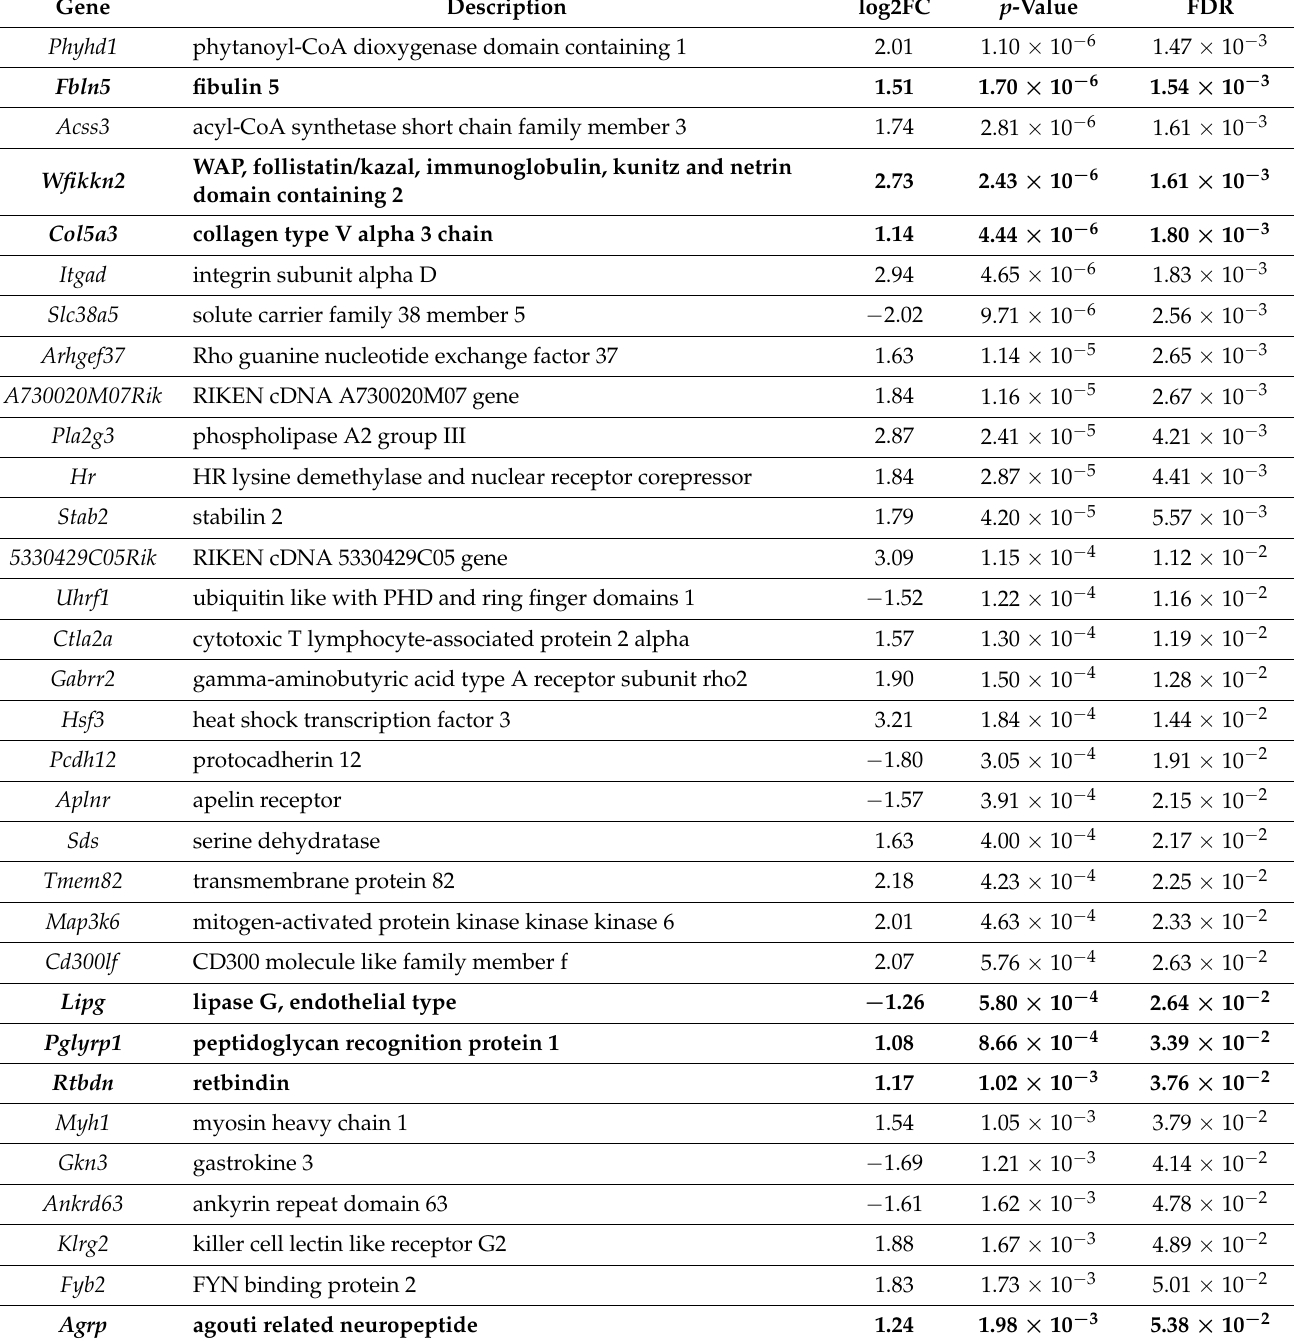
Table 1. The 32 differentially expressed genes (DEGs) in only hypothalamus (FDR ≤ 0.05 and abs(log2FC) > 1.5 or secretory-related genes). Secretory-related genes in the Metazoa Human/Animal Secretome and Subcellular Proteome Knowledge Base (MetazSecKB) or DEGs with an absolute log2 fold change larger than 1.5 and an FDR less than 0.05 are chosen. Secretory-related genes are indicated in